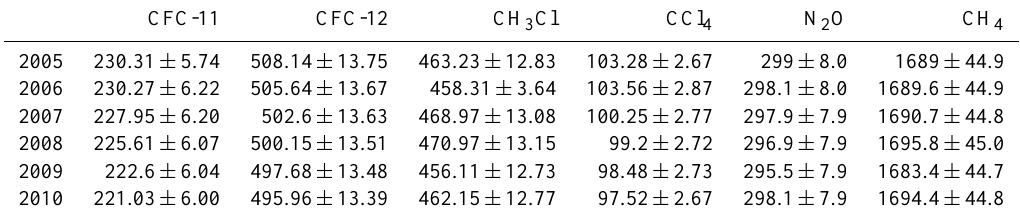
Table A4. Mean atmospheric volume mixing ratio ( ¯ σ) .